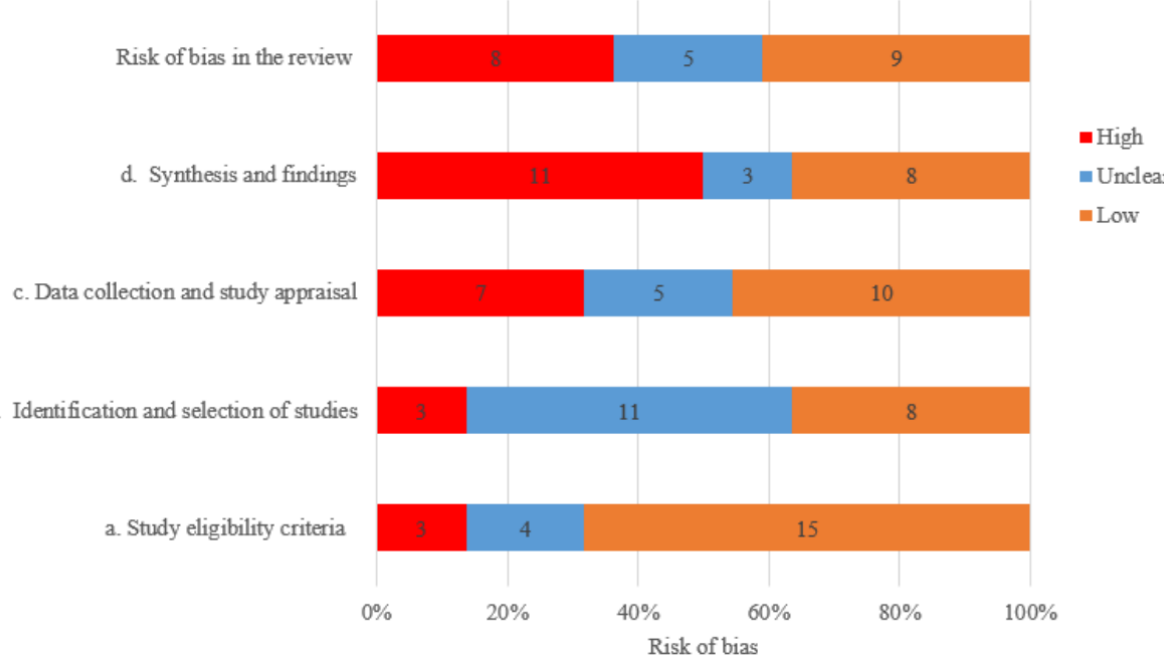
Figure 4. Methodological quality using the Assessment of Multiple Systematic Reviews (AMSTAR) 2. The numbers within the bars represent the number of systematic